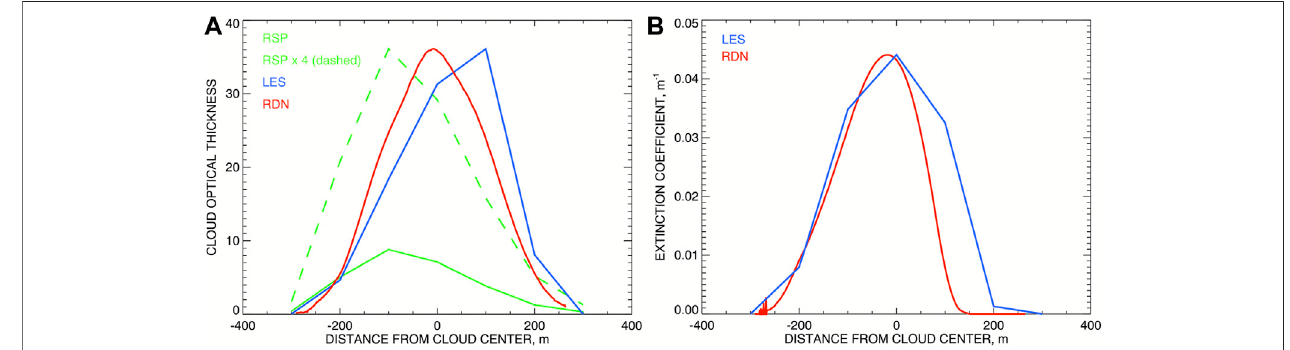
FIGURE 9 | (A) Comparisons of COTs derived in different ways: by integration of the initial LES extinction fi eld (blue), by integration of the backprojected fi eld with subsequentscalingtomatchtheLESCOTmaximum(red),andbyapplyingtheRSPalgorithmtonadir-viewre fl ectances(solidgreen;dashedgreen:thesamemultiplied by 4). (B) Horizontalpro fi les oftheextinction coef fi cient at 1,400 maltitude:blue — from LESdataset, red — from tomographic retrievals scaled tomatch themaximum of the blue